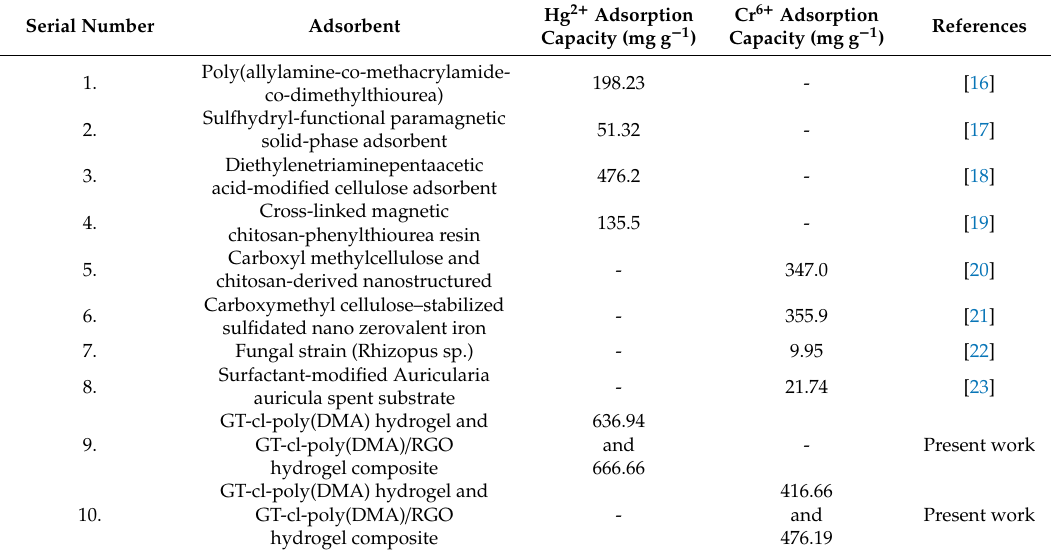
Table 1. Comparison of di ff erent adsorbents with gum tragacanth-cl- N,N -dimethylacrylamide (GT-cl-poly(DMA)) hydrogel and reduced graphene oxide incorporated gum tragacanth-cl- N,N -dimethylacrylamide (GT-cl-poly(DMA) / RGO) hydrogel composite for adsorption of Hg 2 + and Cr 6 + metal ions.